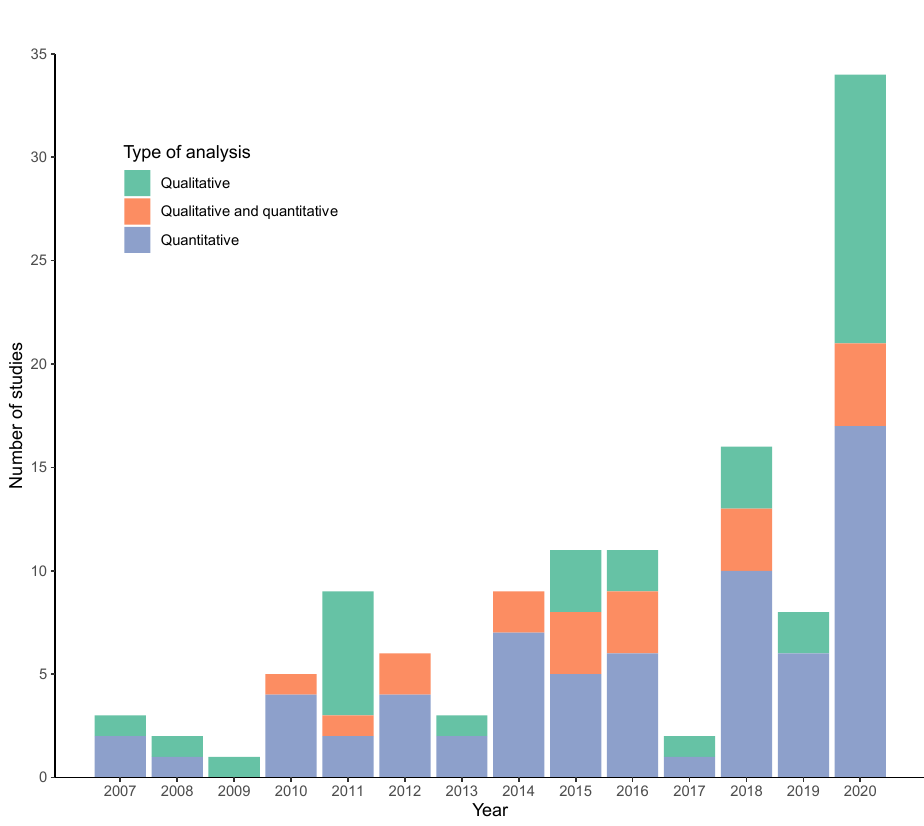
Figure 3. Number of studies published over time, by analysis type.